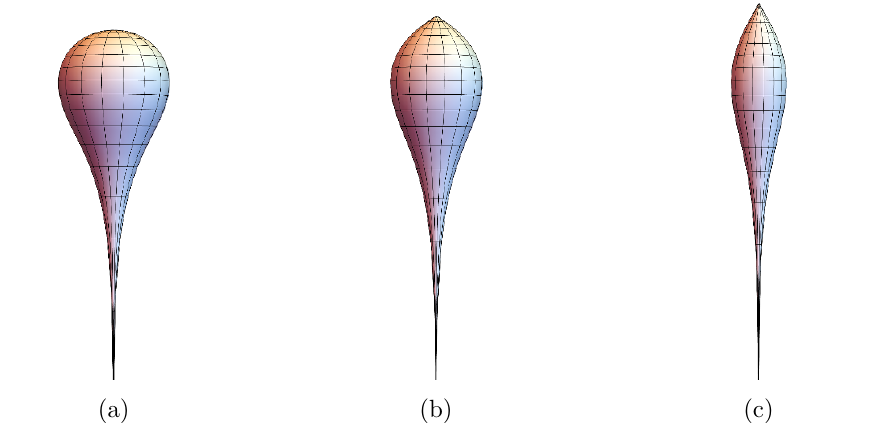
Figure 1. Horizon embedding of critical black holes. We display the horizon embeddings in R 3 of the critical C-metrics for m = 9 ‘ , A = 0 : 04 ‘ and (a) K = 2(cid:4) (b) K = 2 : 4(cid:4) (c) K =